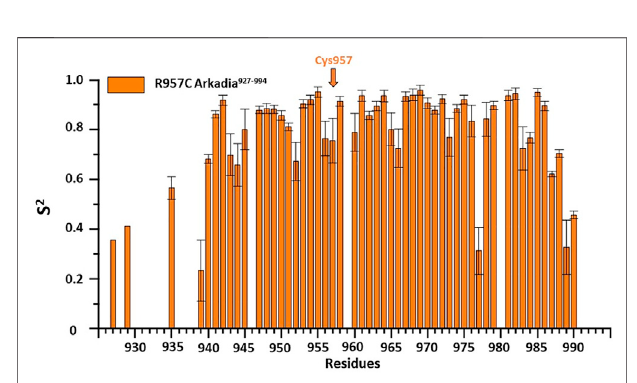
FIGURE 5 | Order parameters ( S 2 ) derived from 15 N-relaxation measurements [ R 1 , R 2 and heteronuclear ( 1 H N ) – 15 N NOE] for R957C Arkadia 927 – 994 domain at 600 MHz and 298